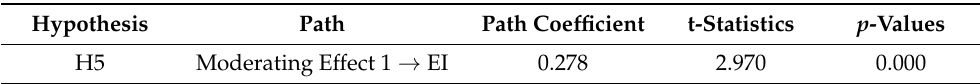
Table 5. Moderation